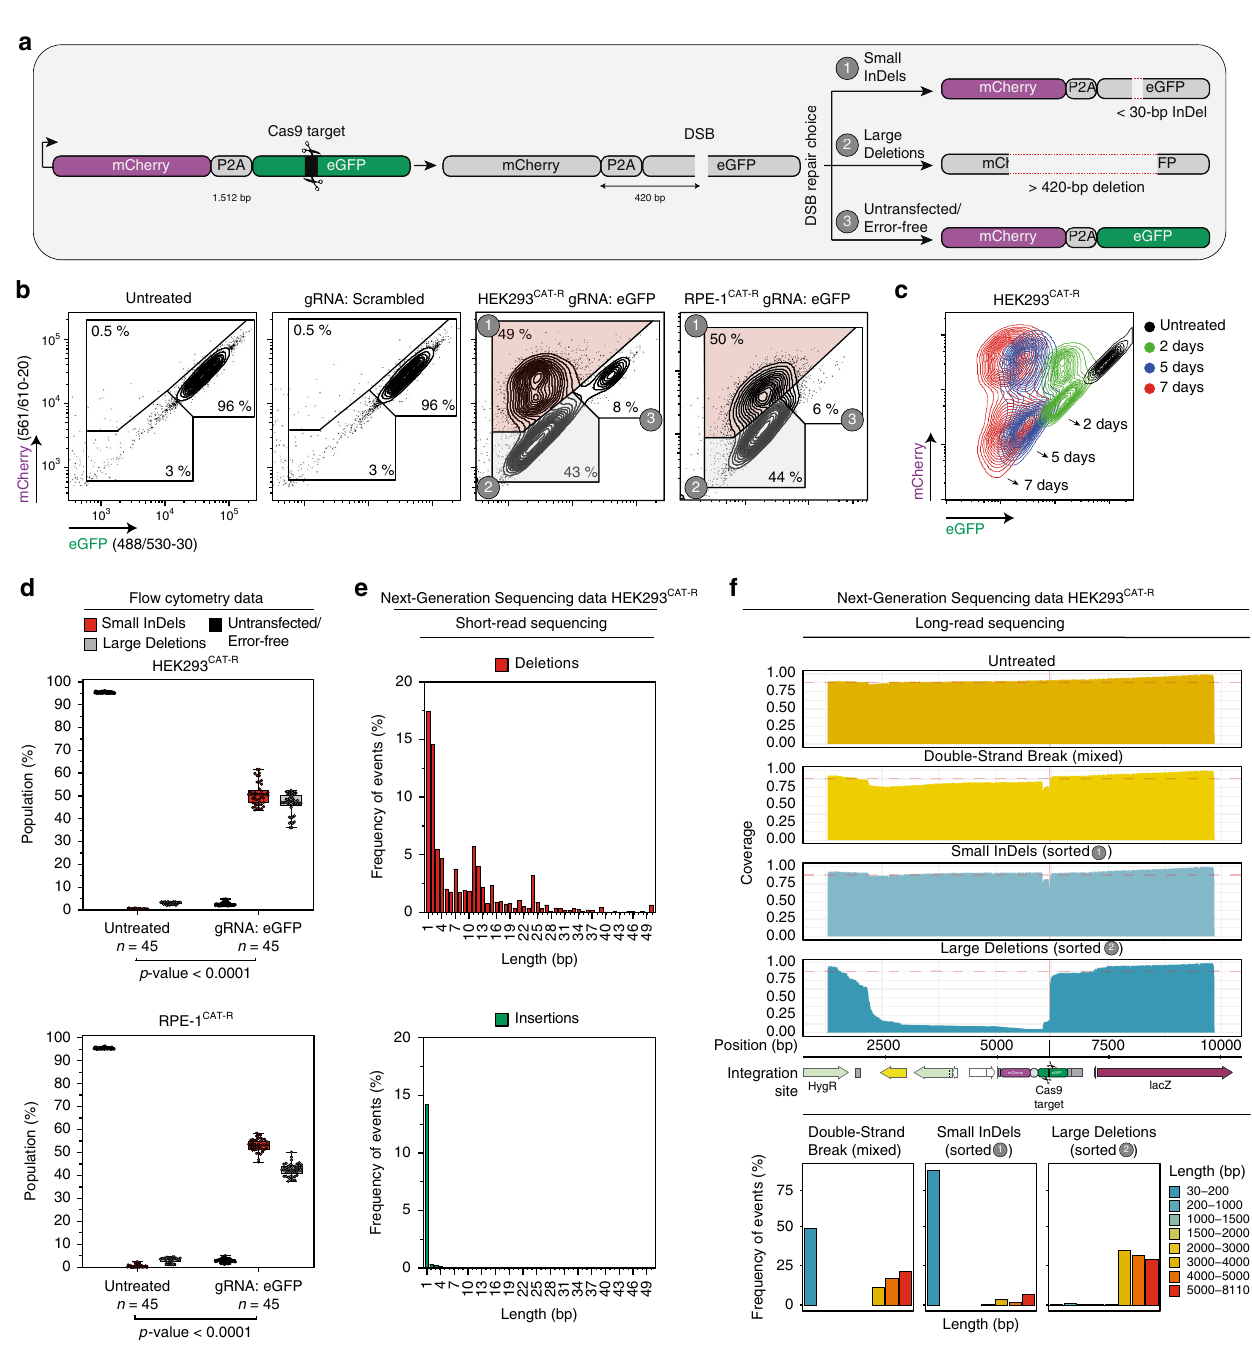
Fig. 1 The Color Assay Tracing-Repair (CAT-R) reporter system. a Representation of the CAT-R reporter showing the different DNA repair outcomes after a Cas9-mediated site-speci fi c double-strand break (DSB). The CRISPR/Cas9 target site is indicated at the eGFP locus 355 bp downstream of the P2A peptide. If the break resolves through repair with small InDels, frameshift mutations will translate eGFP out of frame, and only the mCherry will express; if the break resolves with large deletions both mCherry and eGFP sequences will be lost. For simplicity, we refer to the double negative population as large deletions, but they likely include additional classes of rearrangements. b Flow cytometry plots of HEK293 CAT-R and RPE-1 CAT-R cells 72 h post-transfection with a non-targeting (scrambled) gRNA as control and a gRNA targeting the eGFP coding sequence. Numbers inside plots indicate percentages of live cells. Axes show fl uorescence intensities of eGFP and mCherry proteins. c Overlay of fl ow cytometry plots, monitoring the fl uorescent intensity of HEK293 CAT-R cells for 2, 5, and 7 days following DSB induction. d Box and whisker plot ( n = 45, centerlines mark the medians, box limits indicate the 25th and 75th percentiles, and whiskers extend to min and max, showing all points) of fl ow cytometry analysis for HEK293 CAT-R and RPE-1 CAT-R cell lines 72 h post- transfection with the synthetic gRNA. The p -values are calculated with a multiple comparison analysis testing in ANOVA followed by a Dunnett ’ s test. Data are derived from 15 independent experiments; n represents the number of all replicates. e Short-read PCR amplicon sequencing from genomic DNA harvested 72 h post-transfection to detect small InDels at the targeted site. Y axis shows the frequency of events and the X axis shows the length of detected deletions or insertions at the break site. f Long-read PCR amplicon sequencing from genomic DNA harvested 72 h post-transfection to detect large deletions at the targeted site. Y axis shows the coverage of events and the X axis shows the length of detected deletions at the break site. Bar plots show the frequency of events per